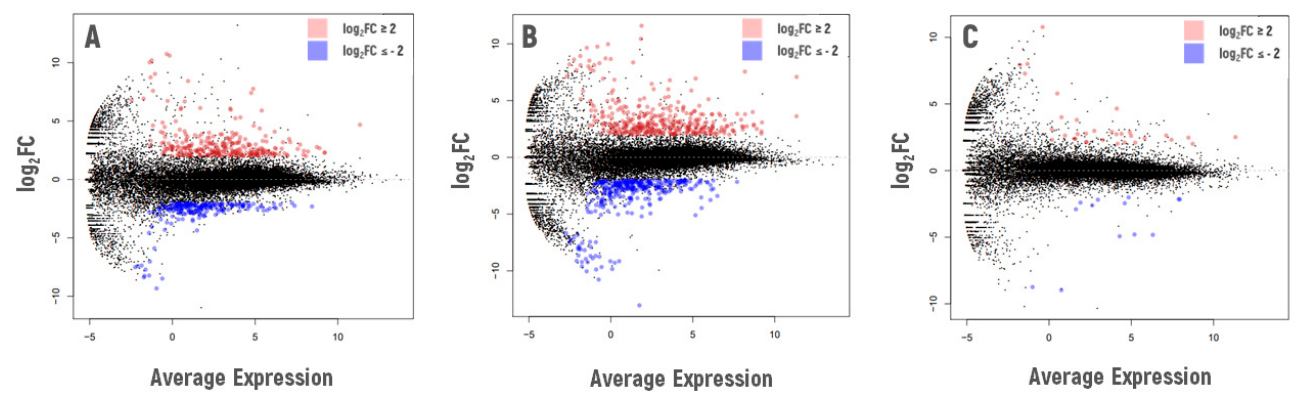
Figure 9. Overview of differential gene expression for additionally irradiated seedlings of A. thaliana selected from three experimental plots (( A )—Bab-0, ( B )—VS-0, ( C )—Masa-0) in comparison with the same accessions without acute irradiation. Log 2 FC—logarithm of gene expression fold change. The graphs were created using the edgeR Package for RStudio v1.4 (R-Tools Technology, Richmond Hill, ON, Canada). Graphical changes were made with Microsoft PowerPoint 2019 (Microsoft Corporation, Albuquerque, NM, USA).